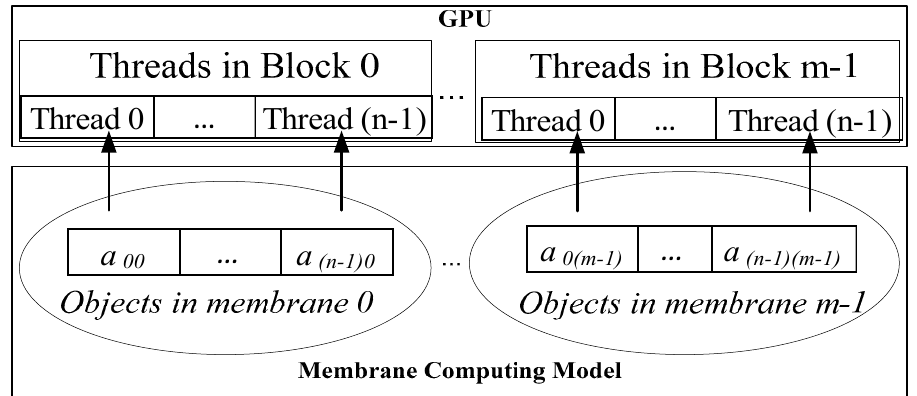
Figure 2. A membrane is assigned to one thread block, and objects are assigned to threads within each thread block [31–33].